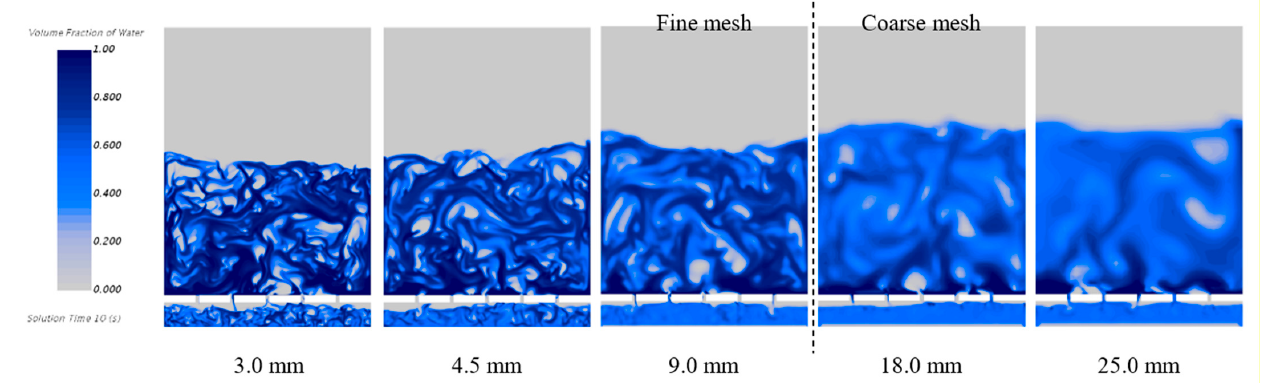
Figure 7. Volume fraction of water. Mesh independence study.